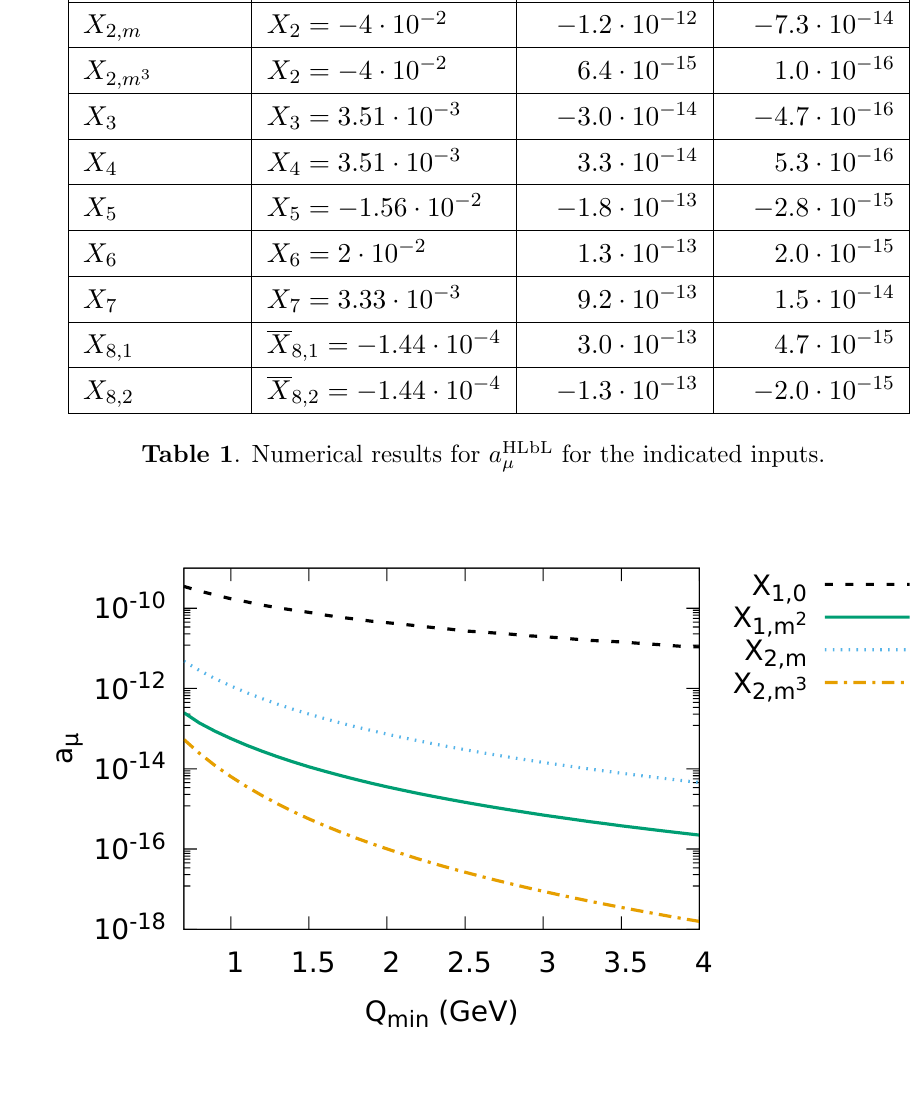
Figure 8 . Numerical contributions from the X 1 and X 2 pieces in absolute value using the inputs from table 1. As expected, the quark loop fully